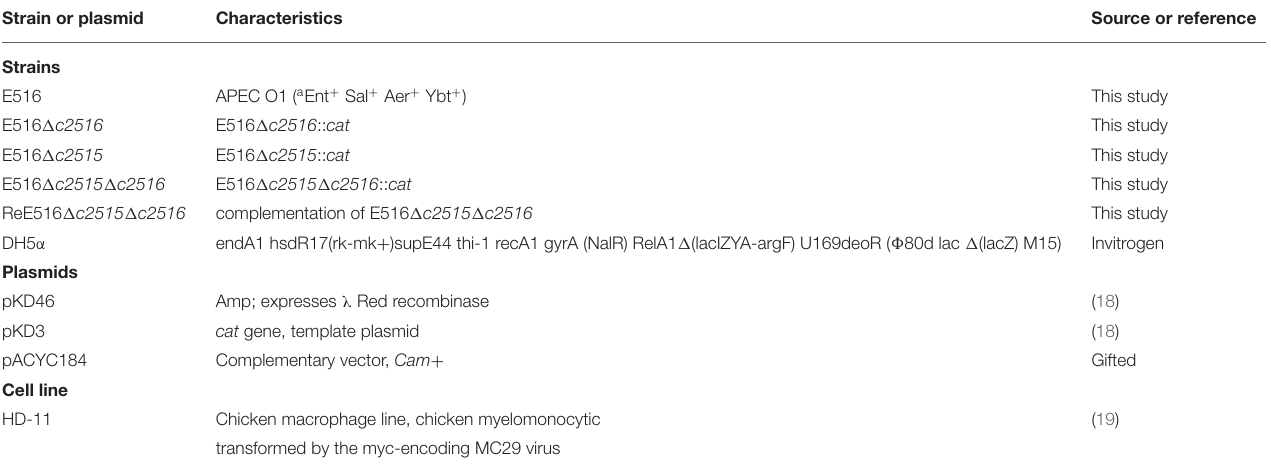
TABLE 1 | Bacterial strains and plasmids used in this study. Strain or